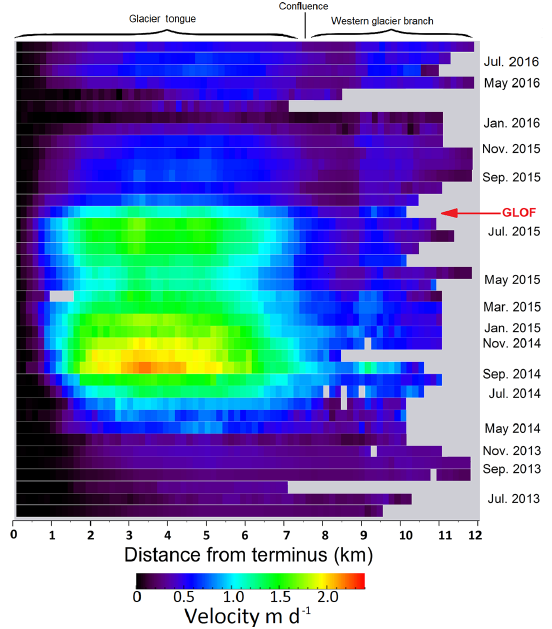
Figure 8. Evolution of surface velocity along the longitudinal pro- file (see Fig. 3) showing the spatial extent of the surge and how it evolved in time. The surge predominately affected the glacier be- low the confluence at 8km. The red arrow indicates the GLOF on 27 July 2015 and the corresponding abrupt deceleration.